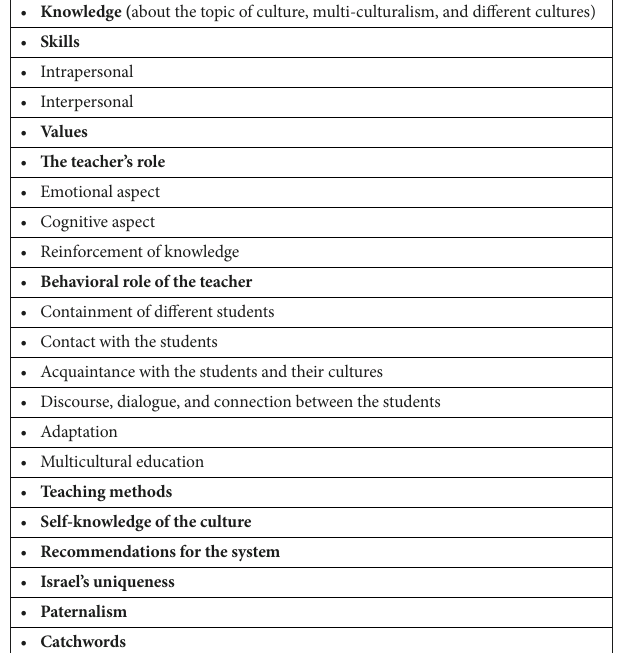
TABLE 2 Categories